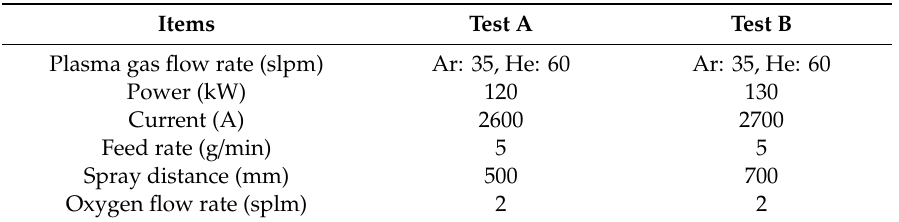
Table 1. Spray parameters for YSZ TBCs prepared by